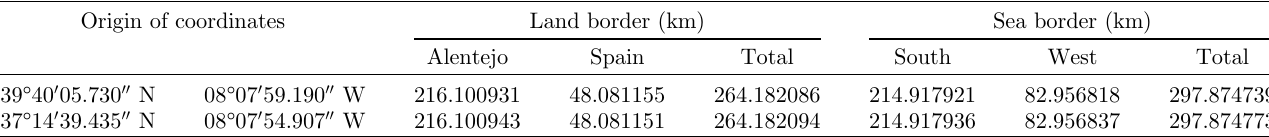
Table 7. Borders of the Algarve by using OAM Algarve (1st line) and NAM Algarve (2nd line) with TMzn. Origin of coordinates Land border (km) Sea border (km) Alentejo Spain Total South West Total